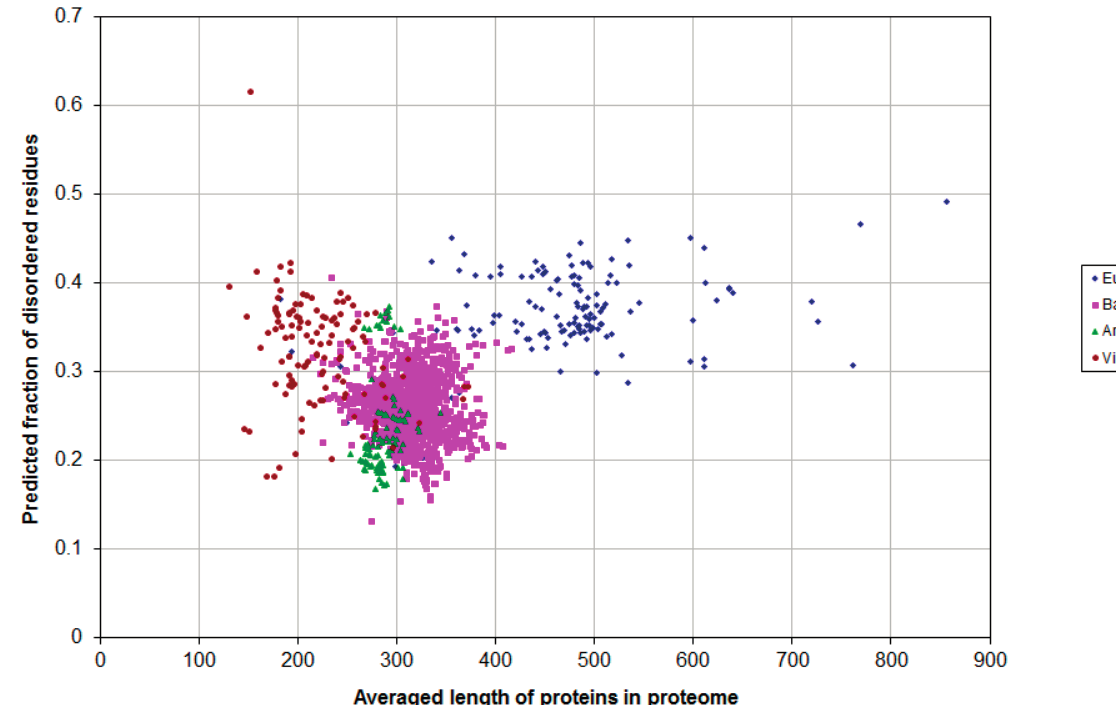
Figure 6. Predicted average fraction of disordered residues for 1902 species from eukaryotes (137), bacteria (1540), archaea (105) and viruses (120) versus the average protein length in the proteome.